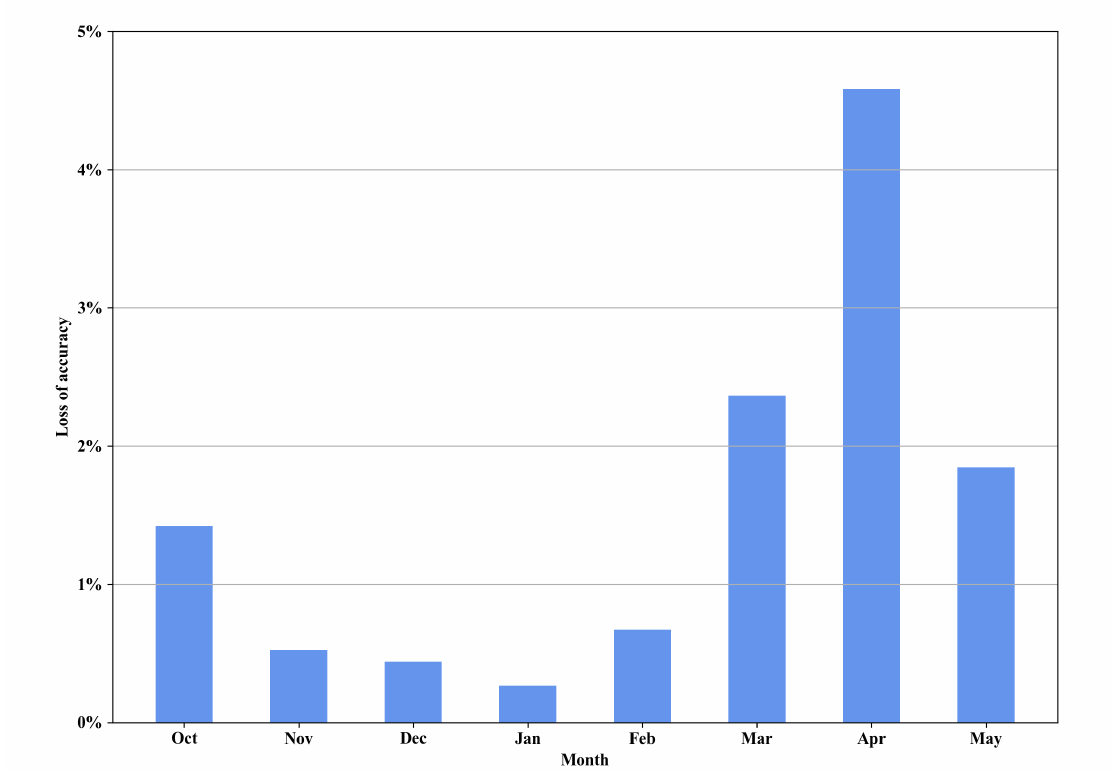
Figure 11. Loss of model accuracy after permuting data of different months compared to the model using complete